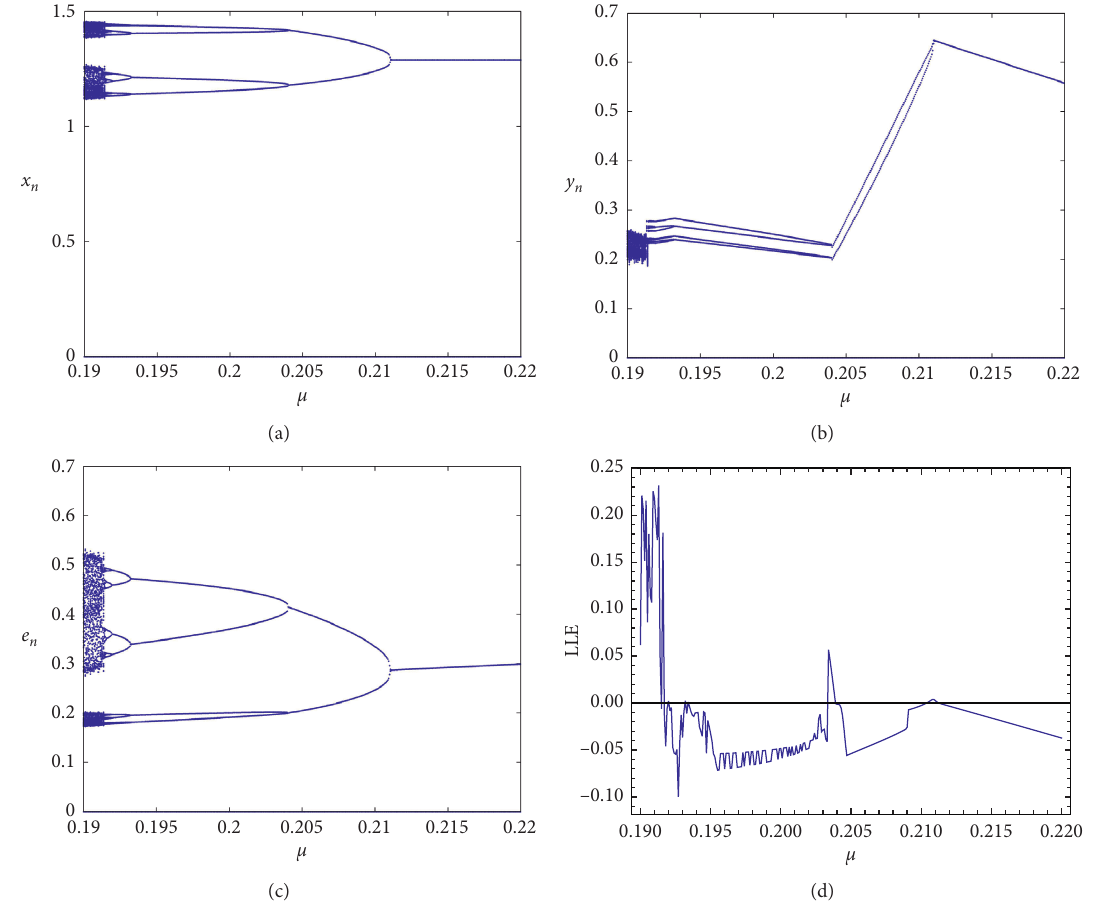
Figure 4: Bifurcation diagrams and LLE for system (3) with a � 5 . 8, b � 8 . 8, c � 2 . 1, d � 3 . 6, k � 2 . 5, r � 1 . 6, p � 2 . 2, h � 0 . 98, ,y , e ) � ( 1 . 28 , 0 . 6428 , 0 . 287 ) . (a) Bifurcation diagram for x μ ∈ [ 0 . 19 , 0 . 22 ] , and ( x 0 0 0 diagram for e n . (d) Largest Lyapunov